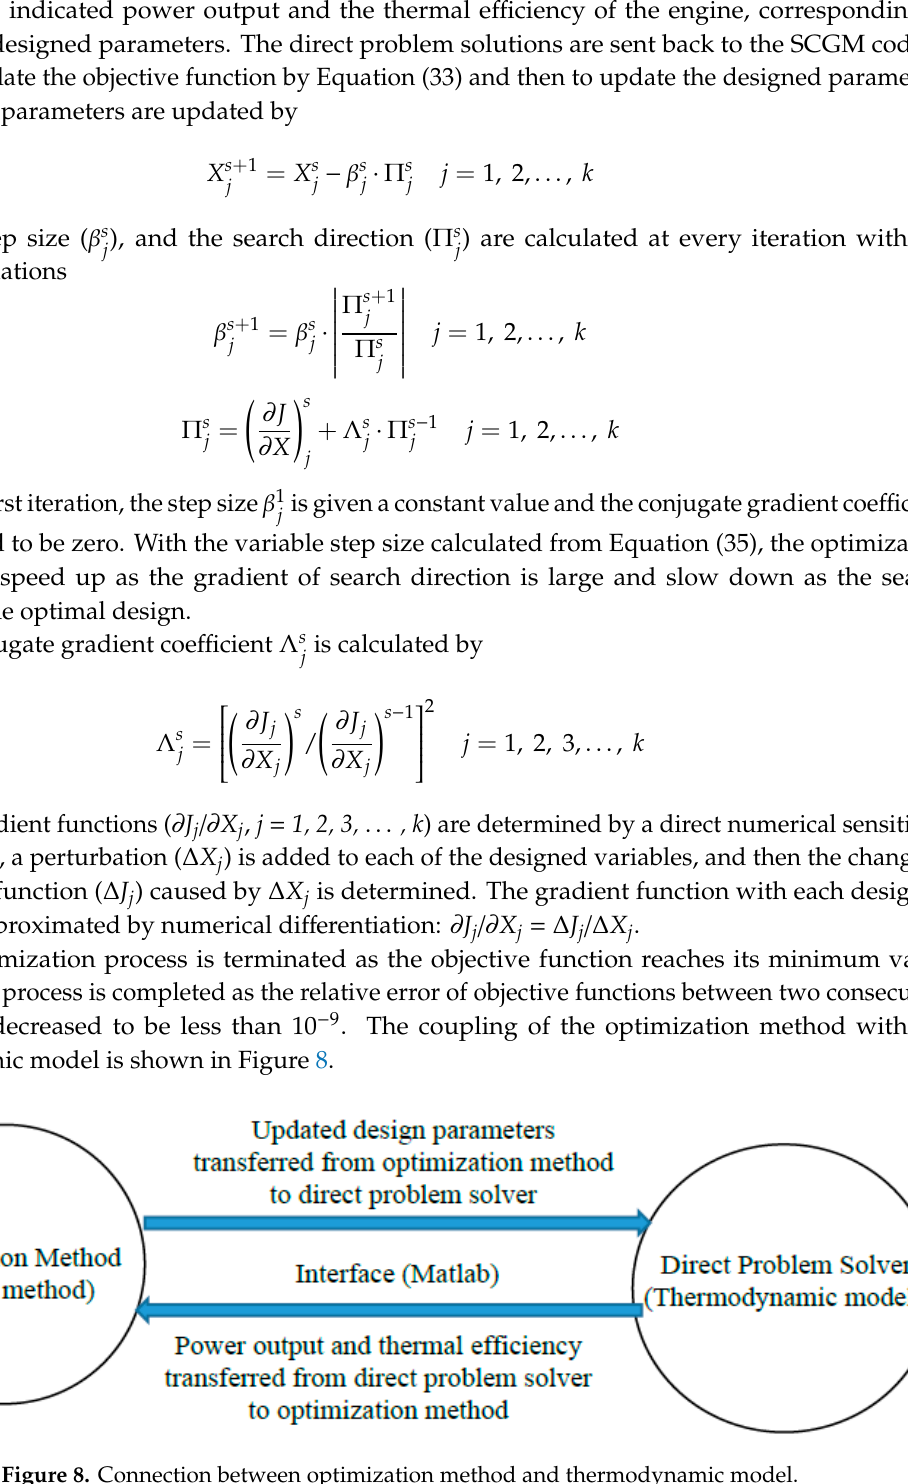
Table 4. Designed parameters and their original values. Table 5. Geometrical constraints. Parameter